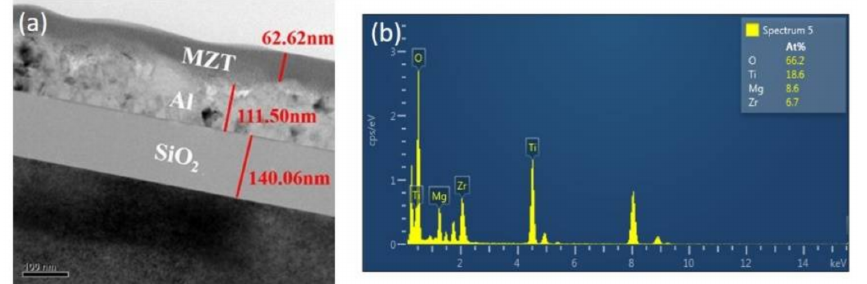
Figure 4. ( a ) TEM image of the MZT/Al/SiO 2 structure. ( b ) Energy-dispersive X-ray spectroscopy (EDAX) analyses of the MZT/Al/SiO 2 /Si